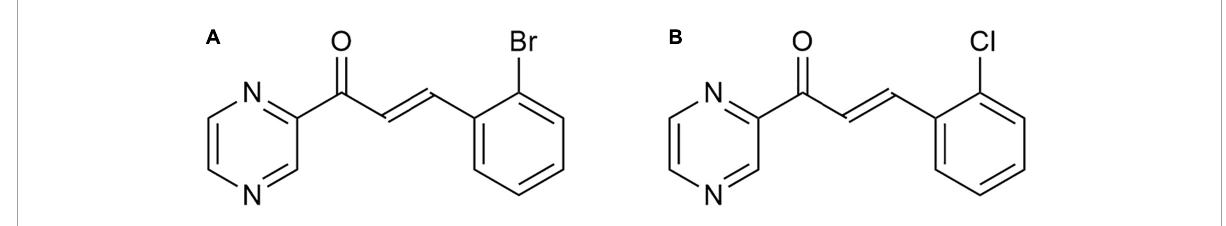
FIGURE1 The structures of the studied compounds CH-0y (A) , and CH-0w (B) , created using ChemDraw 20.0 (PerkinElmer).